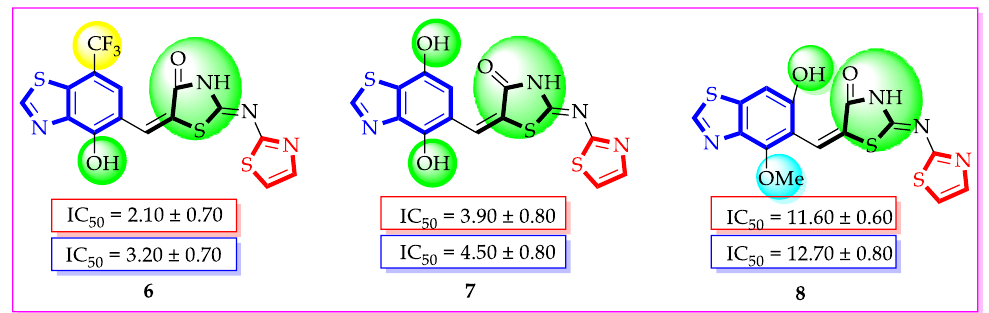
Figure 5. SAR study of analogues 6 , 7 , and 8.